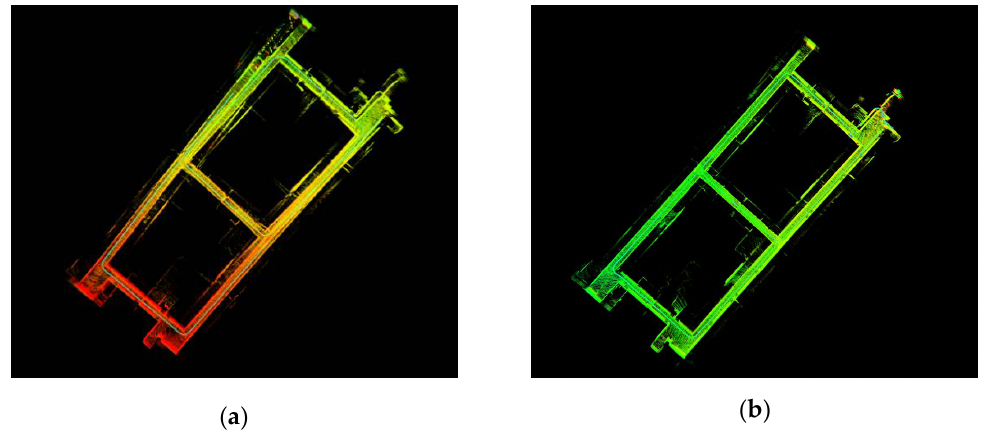
Figure 7. Effect of loop detection on localization and map building: ( a ) Without loop detection and ( b ) with loop detection. ( b ) with loop detection.